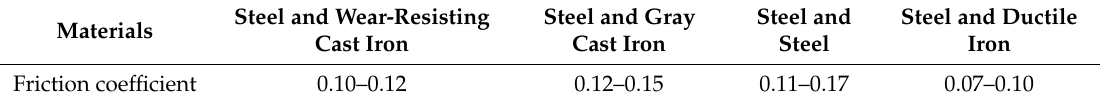
Table 2. Friction coefficients between different materials for the nuts and steel bolt rod.